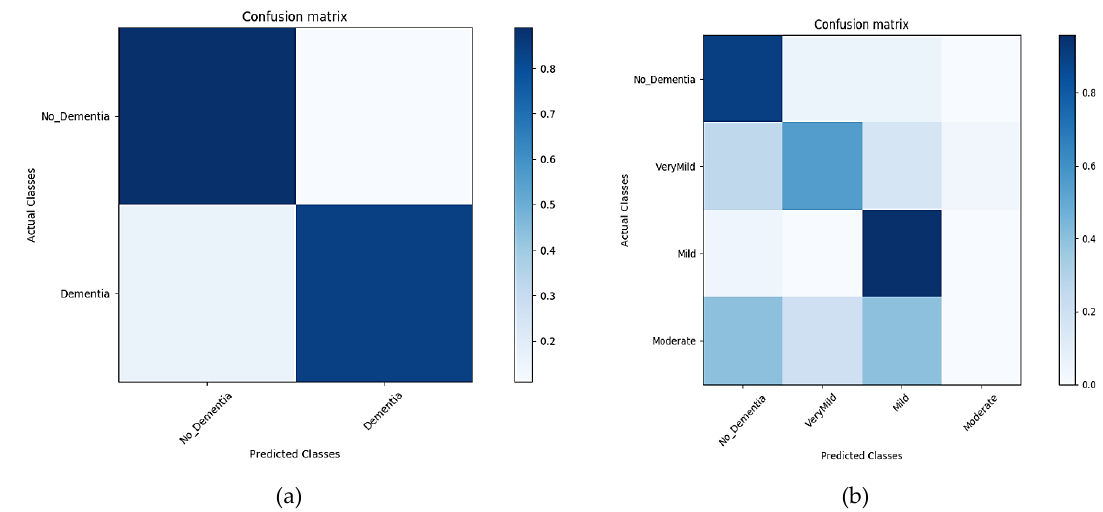
Figure 7. The confusion matrix of the Segment1 dataset ( a ), representing the confusion matrix of the binary dataset. ( b ) A confusion matrix of multiple classes.